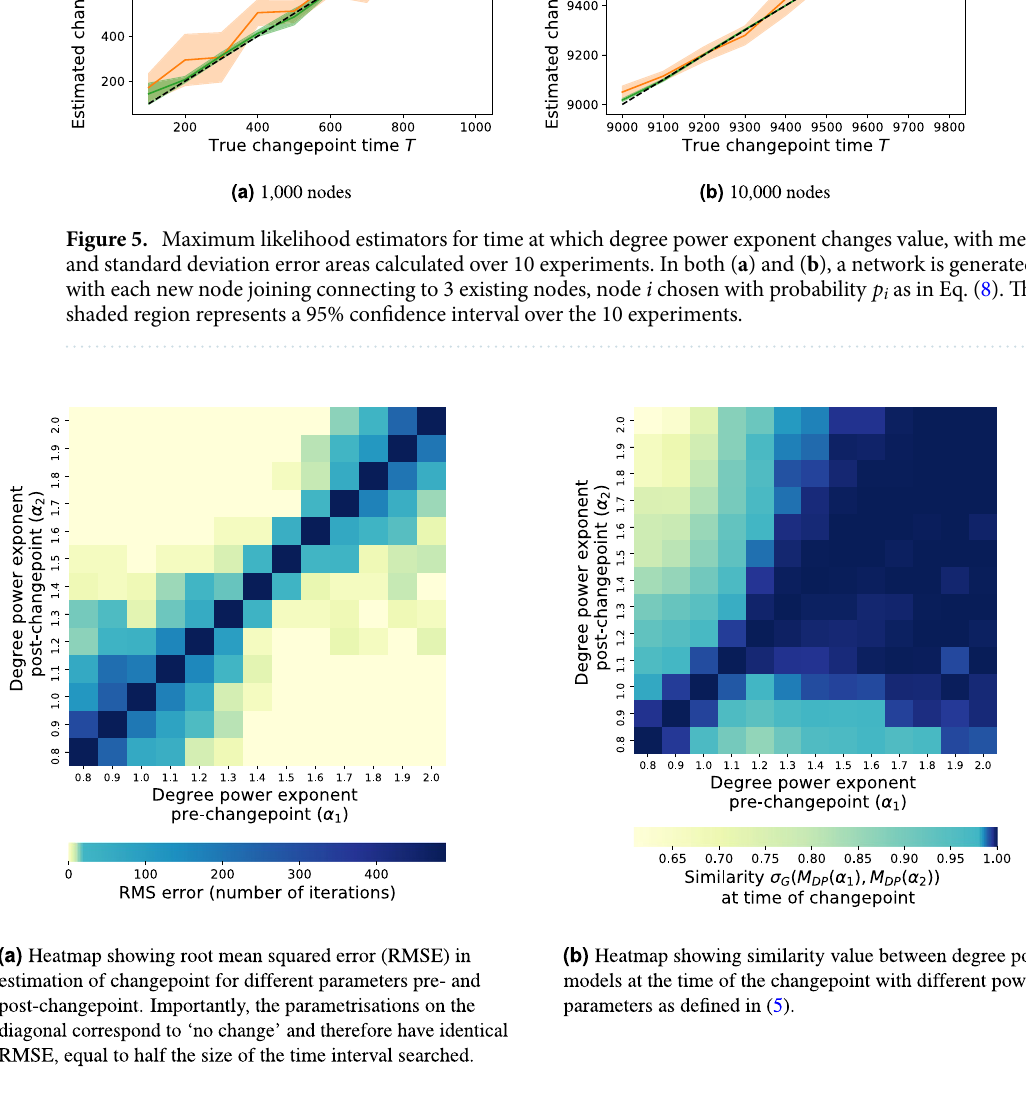
Figure 6. Experiments on a 10,000 node network generated using object model described in Eq. (8). The operation model used is to at each iteration, add a single new node and connect to 3 existing nodes (i.e. an external